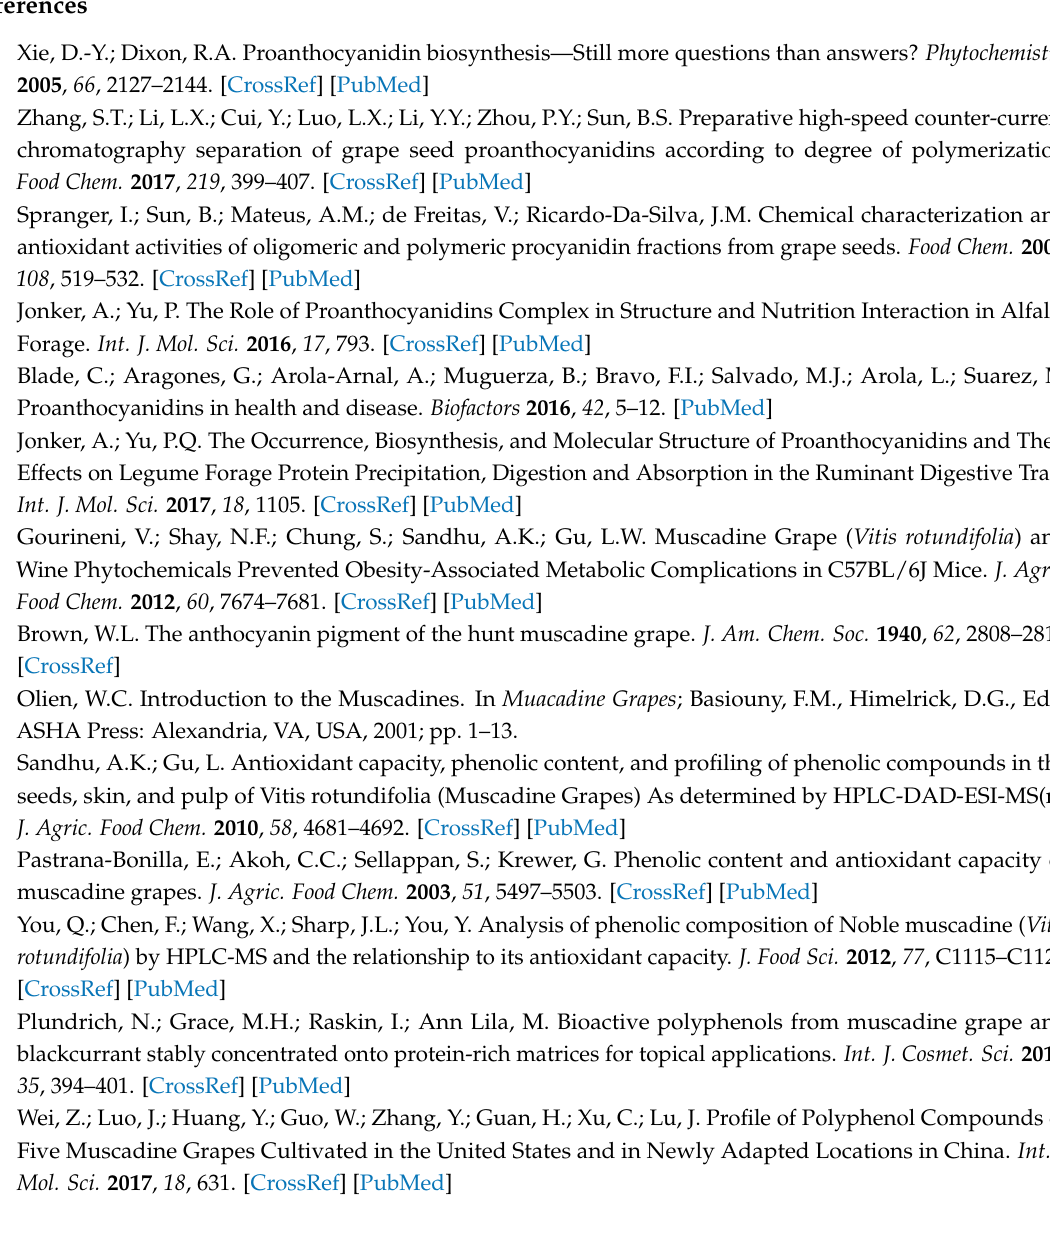
Figure S21. Extracted ion chromatogram (EIC) of primary mass spectrum (MS1) and m / z features of secondary ion fragments (MS2) derived from LC-MC/MS; annotate this peak to be procyanidin B7 (MW, 578.52). Figure S22. Extracted ion chromatogram (EIC) of primary mass spectrum (MS1) and m / z features of secondary ion fragments (MS2) derived from LC-MC/MS; annotate this peak to be procyanidin B8 (MW,